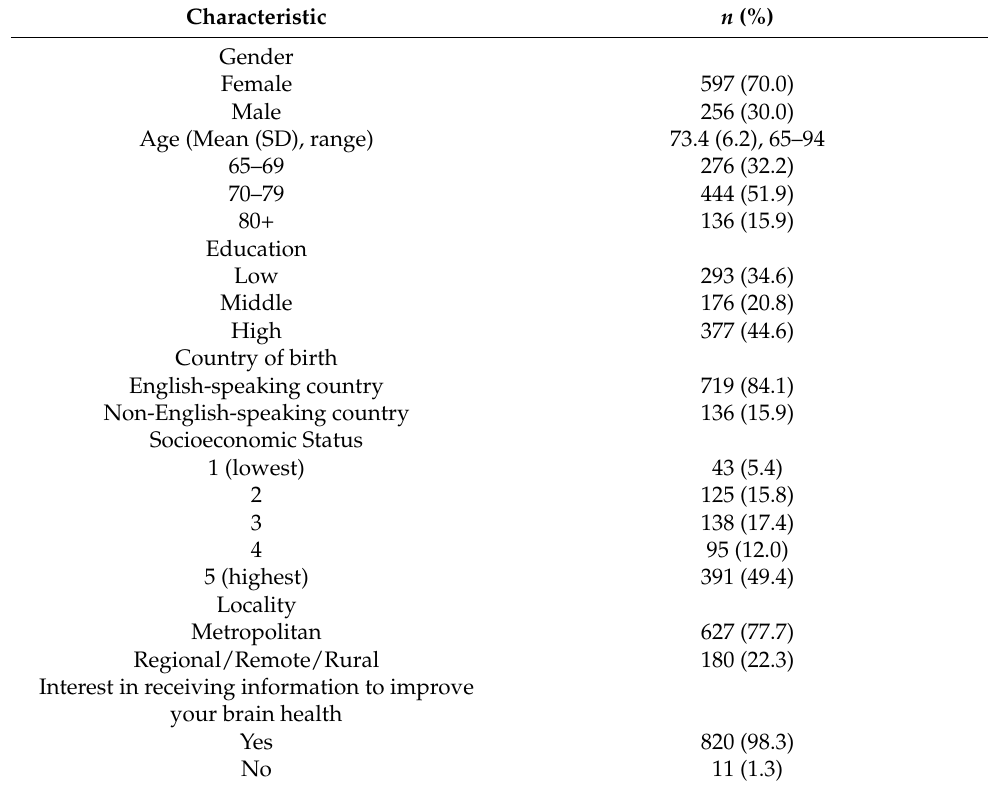
Table 1. Summary of participant characteristics ( n = 857).